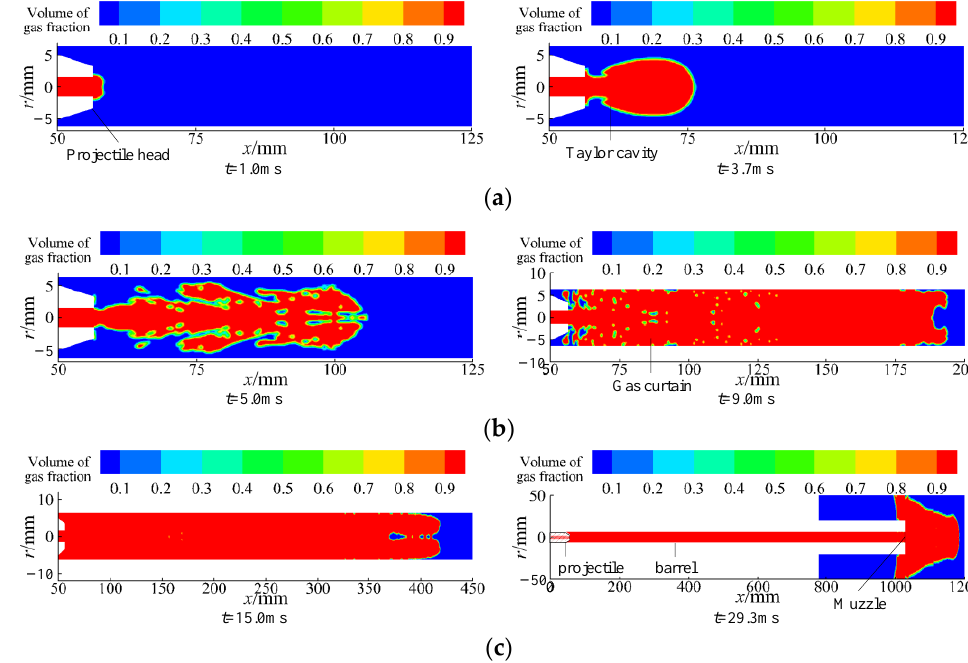
Figure 6. The gas-curtain evolution process (projectile A). ( a ) The first stage; ( b ) the second stage; ( c ) the third stage.